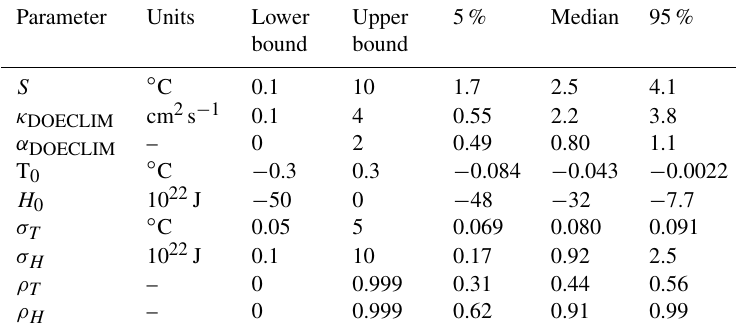
Table A1. Prior probability distribution ranges for the DOECLIM climate model parameters, and median, 5th, and 95th quantiles of the calibrated posterior parameter distributions. The priors are all uniformly distributed.